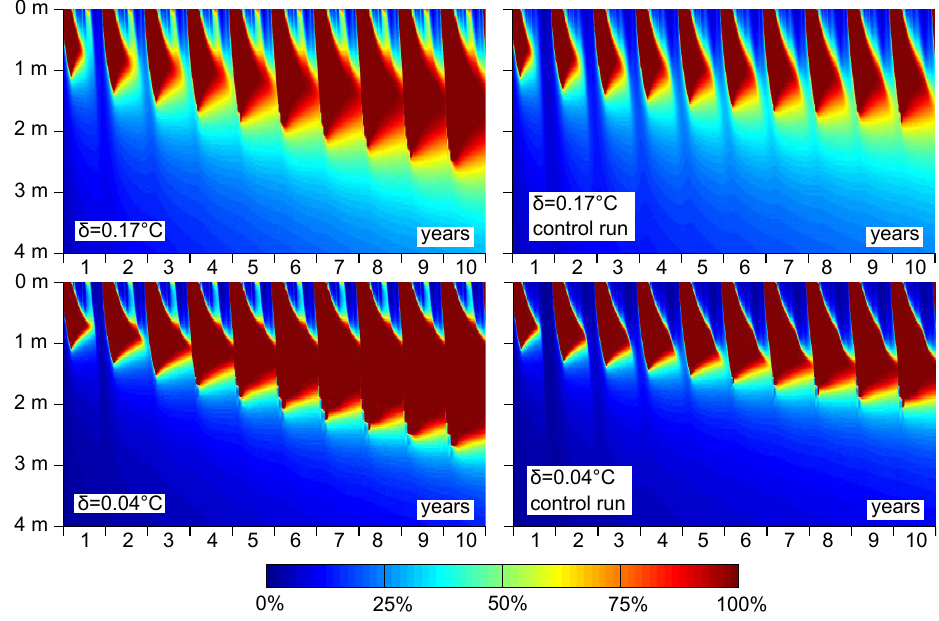
Fig. 6. Results of scenario runs, where the forcing of the period July 2005 to June 2006 is applied for ten consecutive years. Fraction of unfrozen soil water relative to the potentially freezable amount (0%: θ w = θ min w ; 100%: θ w = θ max w , see Eq. 4). The model is initialized with measured (0 to 1.5 m depth) and estimated ( > 1.5 m depth) soil temperatures of 1 July 2005. Left: model run including infiltration of rain water in the snow. Right: control run. Top: flat soil freezing characteristic leading to a high content of unfrozen soil water at subzero temperatures ( δ = 0 . 17 ◦ C, as assumed for the study site). Bottom: steep soil freezing characteristic leading to a low content of unfrozen soil water at subzero temperatures ( δ = 0 . 04 ◦